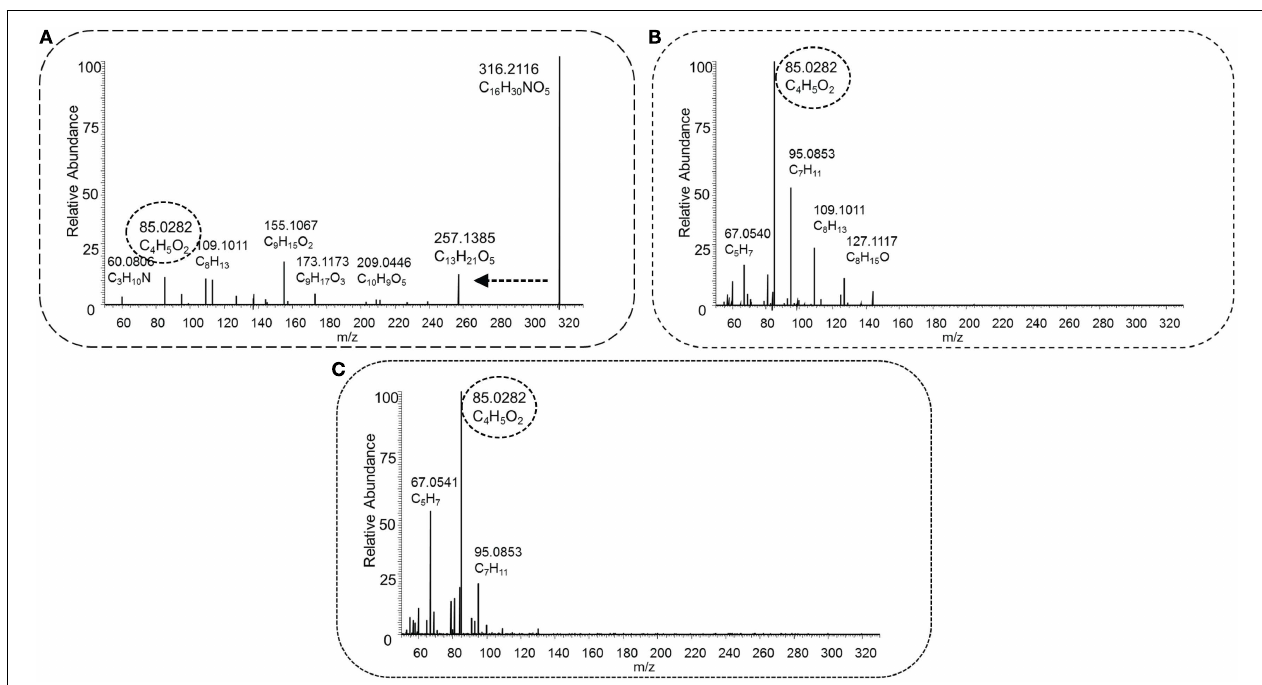
C 16 H 29 NO 5 .The key fragment C 4 H 5 O 2 , marked with a dashed oval, and the neutral loss C 3 H 9 N, indicated by a dashed arrow, occur in the spectra, and this fragmented metabolite could be annotated as an acylcarnitine.